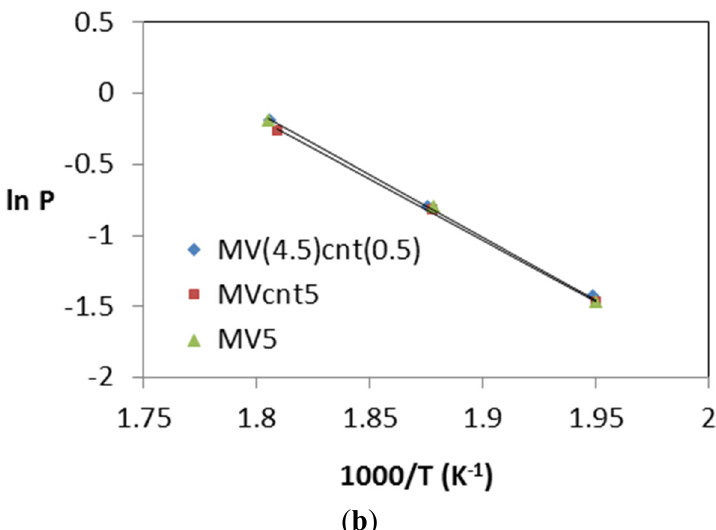
Figure 12. ( a ) Desorption kinetic plots of MV(4.5)cnt(0.5) showing that hydrogen desorption equilibrium was reached at all temperatures; ( b ) van’t Hoff plot for desorption of MV5, MVcnt5 and MV(4.5)cnt(0.5), respectively.